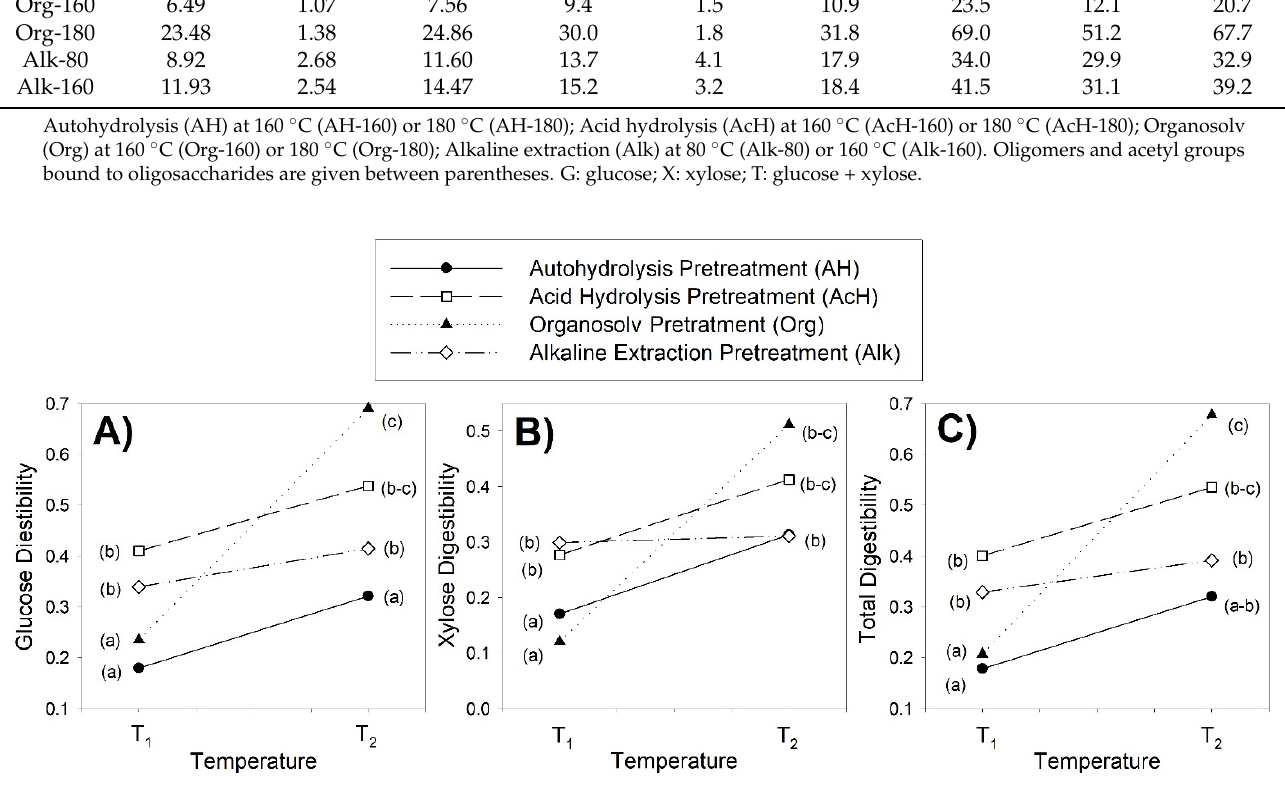
Figure 7. Analysis of digestibility of the different pretreated materials: ( A ) glucose digestibility; ( B ) xylose digestibility; and ( C ) total digestibility. T 1 , pretreatment temperatures at 160 °C, except for alkaline extraction at 80 °C. T 2 , pretreatment temperatures at 180 °C, except for alkaline extraction at 160 °C. Lines with the same letter for initial and final temperature are not significantly different (Tukey test, p < 0.05).